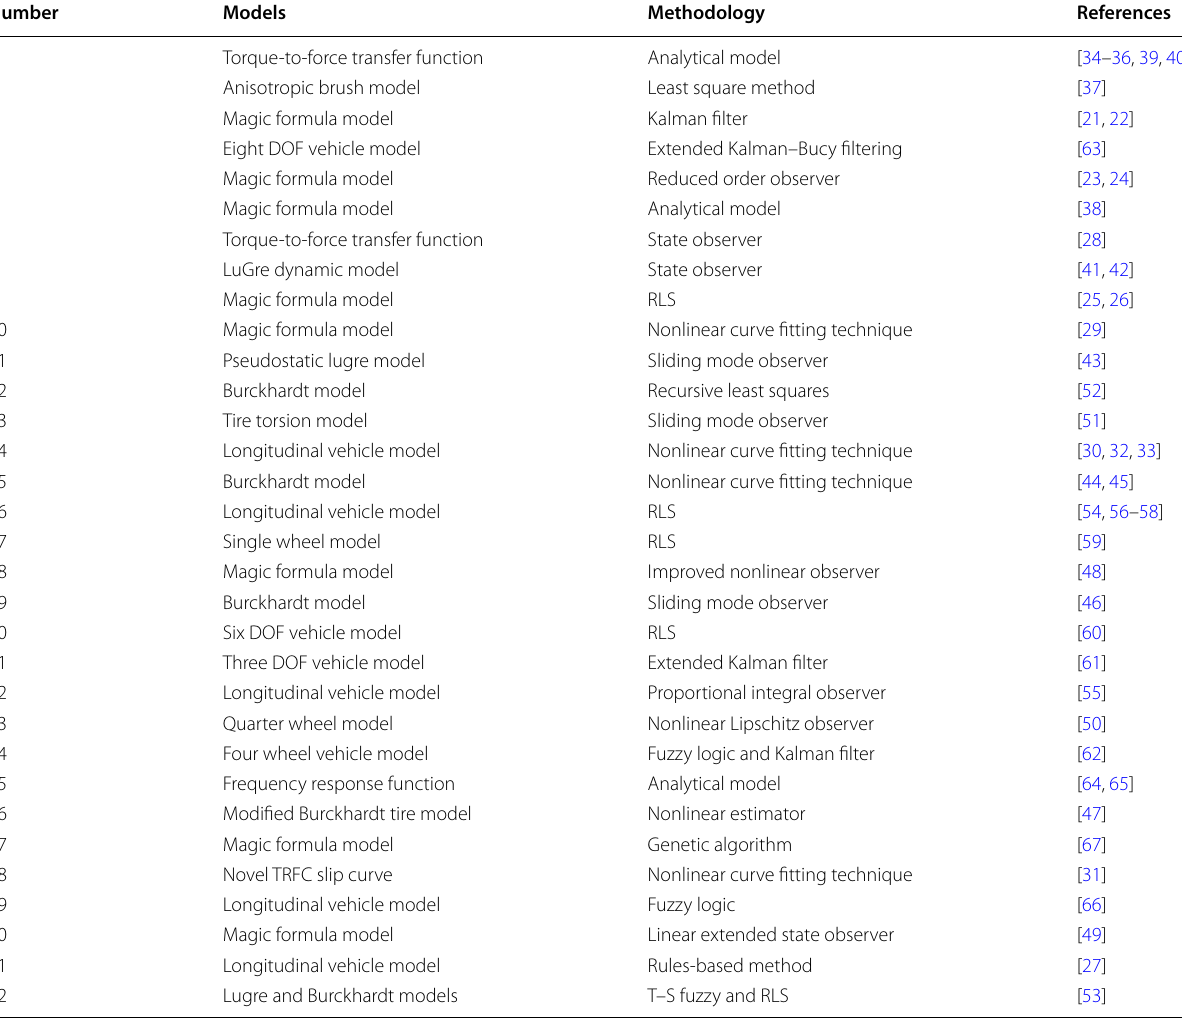
Table 1 Summary of estimation methods based on vehicle longitudinal dynamics